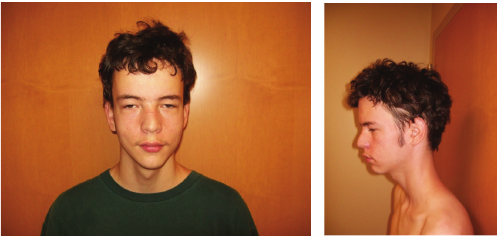
Figure 1: The proband presented with dysmorphic facial features, ptosis, long and narrow face, small chin, long philtrum, and high narrow palate.